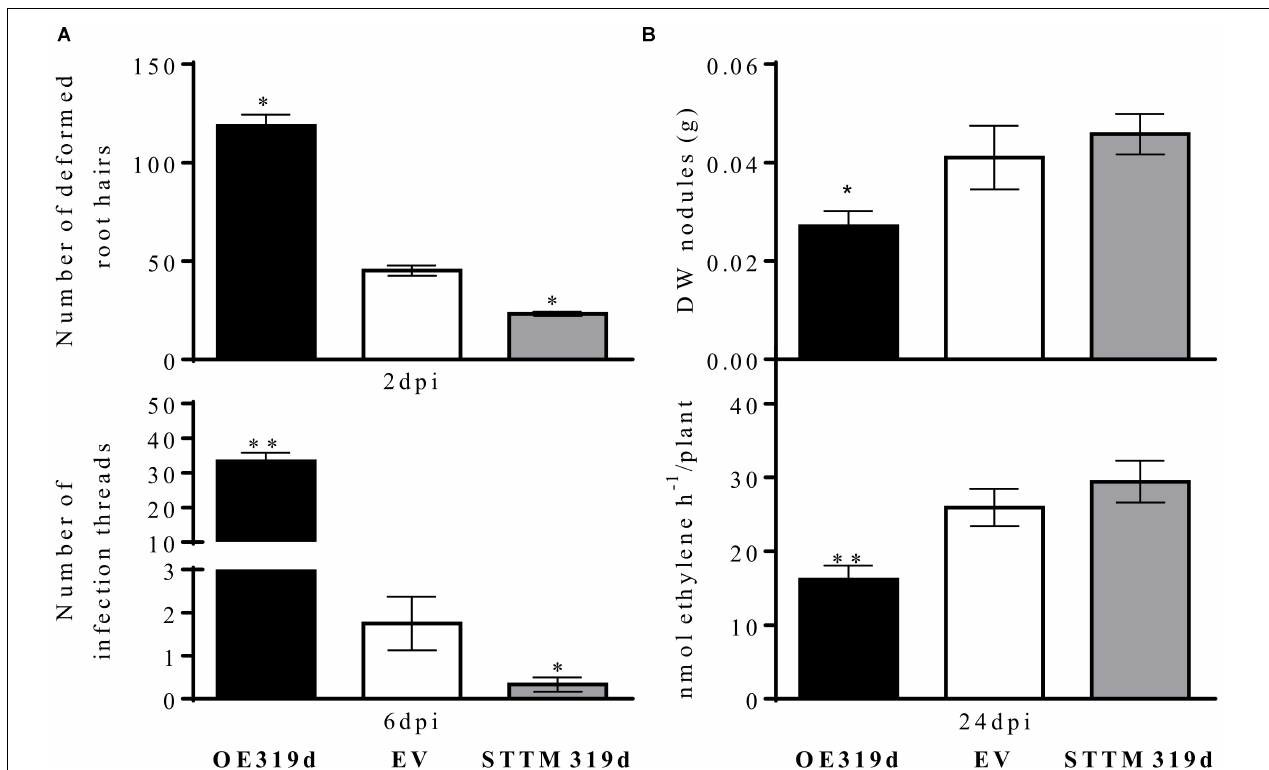
FIGURE 5 | miR319d and TCP10 control the rhizobial infection, nodulation and nitrogen fixation of R. tropici -inoculated common bean plants. (A) At 2 and 6 dpi, the responsive zone of OE319d, EV or STTM319d inoculated roots were harvested for quantification of the number of deformed root hairs (branched and swollen root hairs) and of infection threads per 0.5 cm, respectively. (B) Dry weight of nodules and nitrogenase activity were determined at 24 dpi. Black histograms: OE319d, gray histograms: STTM319d, EV white histograms. Values represent means ± SD from roots of 10 to 20 independent composite plants each. The Mann–Whitney null hypothesis statistical test is relative to EV control data ( ∗ and ∗∗ represent a p- value < 0.05 and p- value < 0.01,